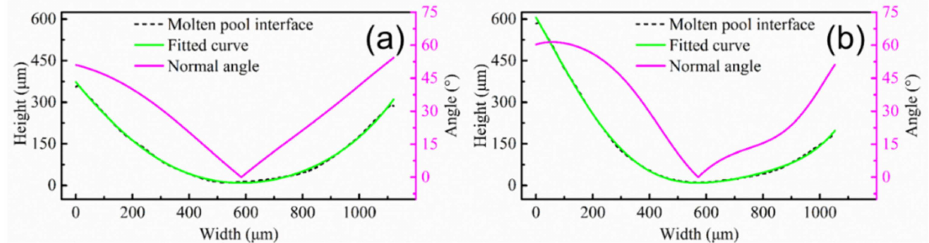
Figure 5. Molten pool interface and normal angle with different z-increment: ( a ) 0.2 mm; ( b ) 0.4